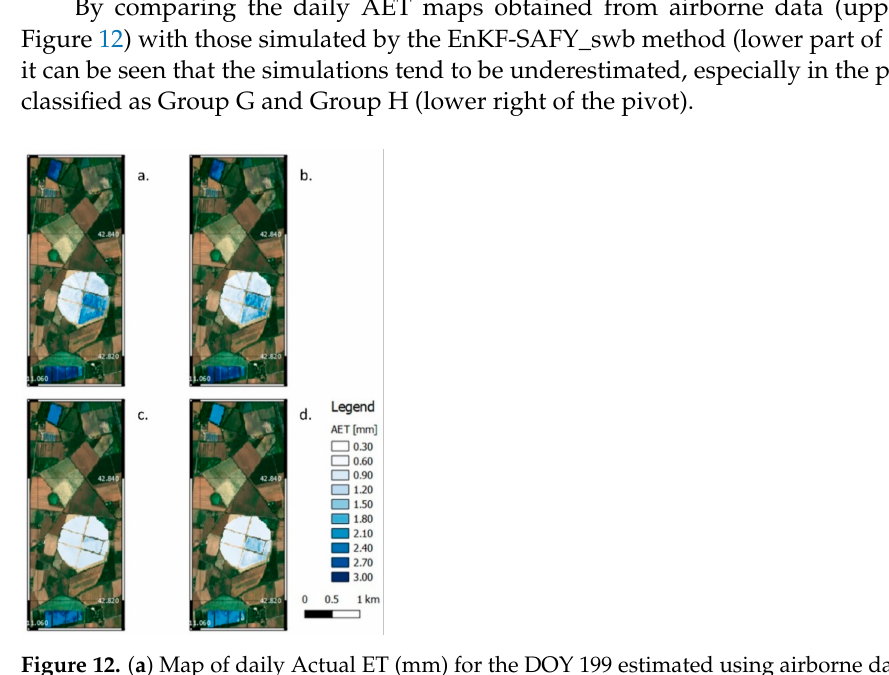
Figure 12. ( a ) Map of daily Actual ET (mm) for the DOY 199 estimated using airborne data. ( b ) map of Actual ET (in mm) for the DOY 201 estimated using airborne data; ( c ) map of Actual ET for the DOY 199simulated using EnKF-SAFY_swb; ( d ) map of Actual ET for the DOY 201simulated using